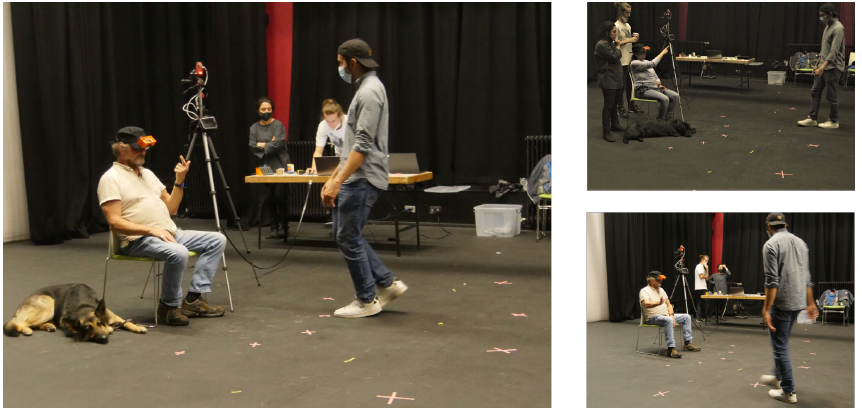
Figure 3. Scenes from the workshops: The deafblind participant sits on a chair adjacent to the radar, whilst the subject to be detected moves through different positions within the field of view of the radar.